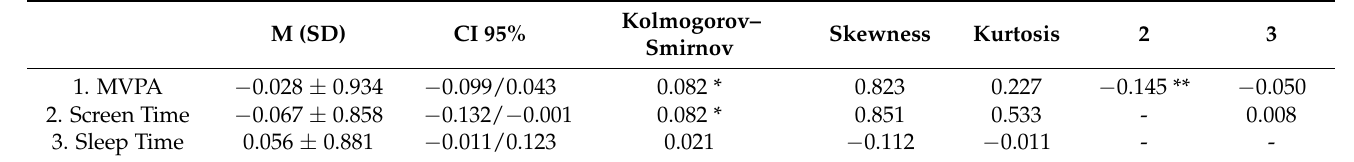
Table 3. Descriptive statistics and z-score correlations of the research variables.